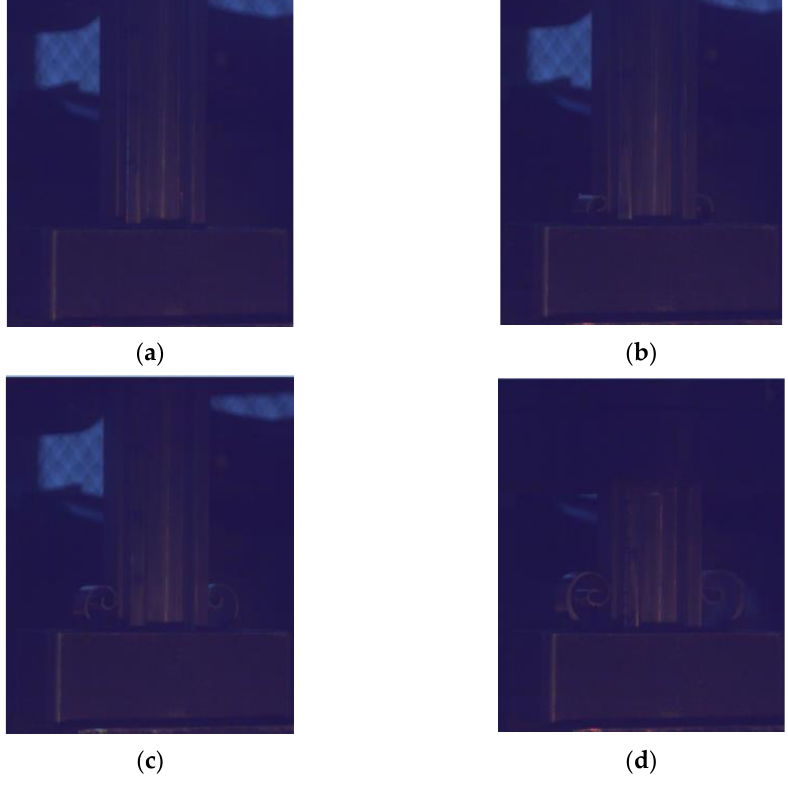
Figure 4. Test process: ( a ) 0; ( b ) 10 ms; ( c ) 20 ms; ( d ) 42 ms.